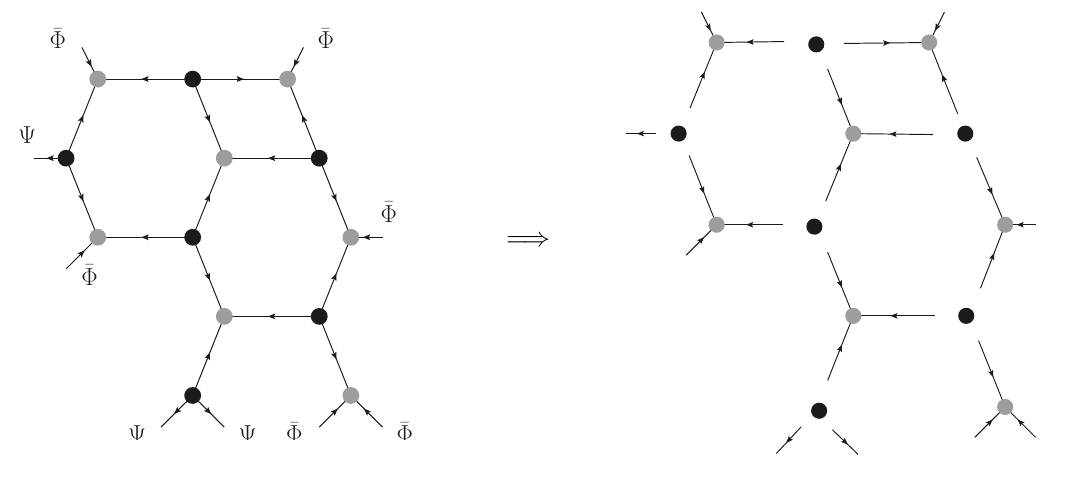
Figure 1 . A generic = 1 supergraph is split into vertex functions. Gray blobs denote chiral N vertices (cid:8) 3 and black blobs denote antichiral vertices (cid:22)(cid:8) 3 . Arrows represent the chirality